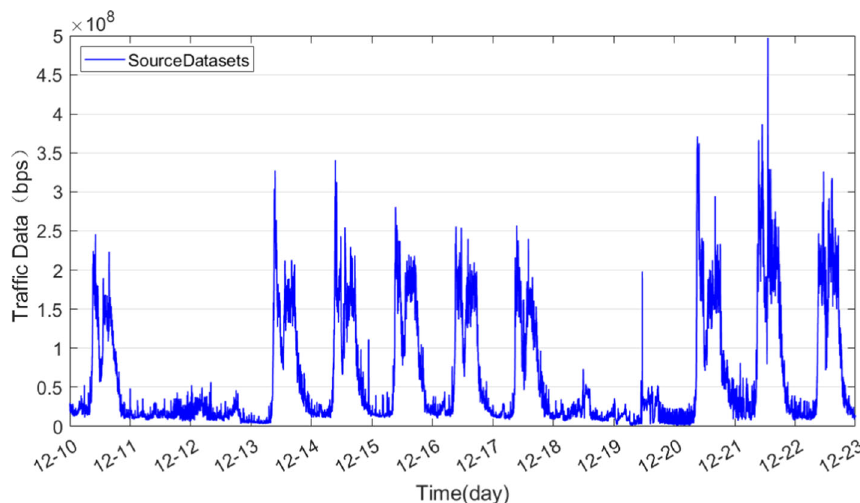
Fig. 1 The traffic data from